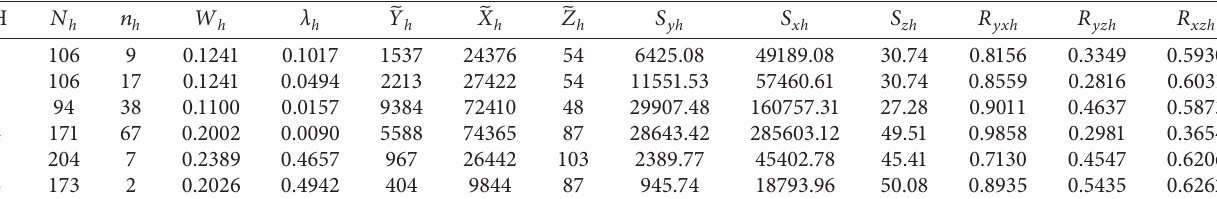
Table 4: Data description of population 2 (scenario I).